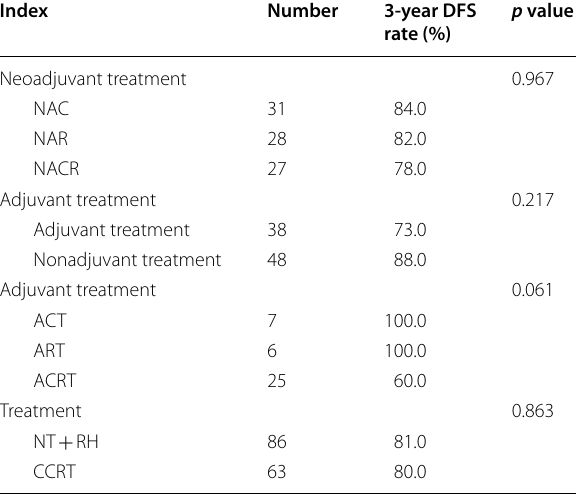
Table 4 Comparison of the 3-year DFS rate of different treatment modalities in NT group and between NT group and CCRT